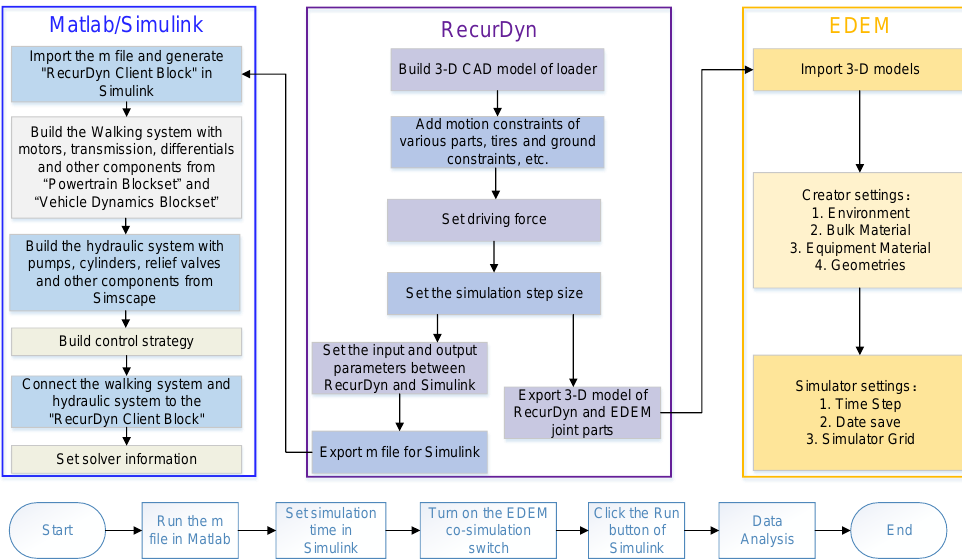
Figure 6. Matlab/Simulink-RecurDyn-EDEM joint simulation